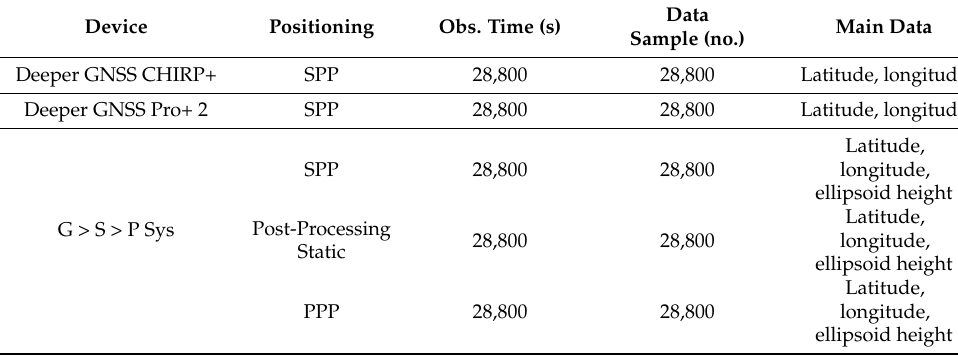
Table 3. Static datasets